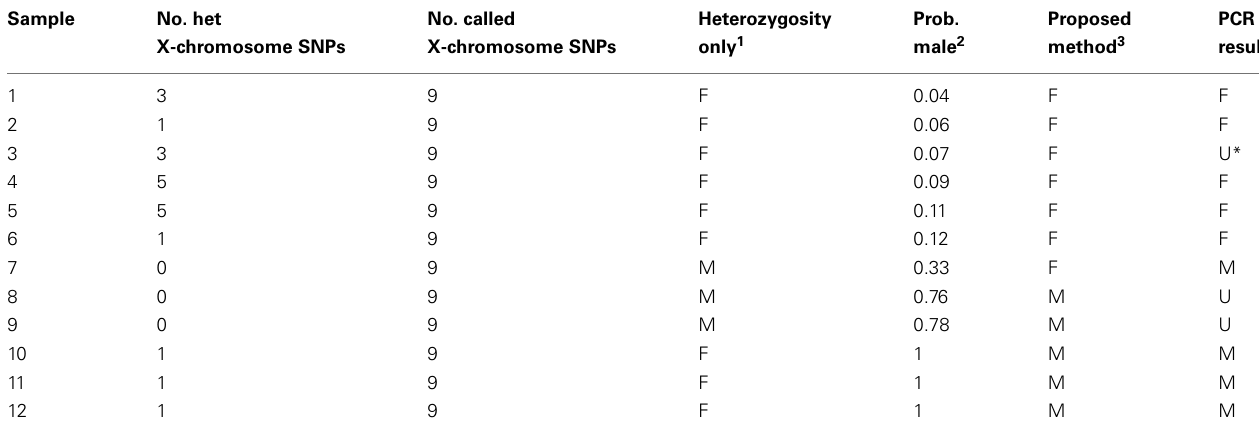
Table 4 | Summary of results for female-labeled samples flagged by our approach. Sample